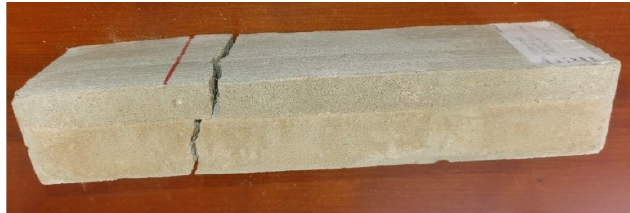
Figure 28. Detail of delamination- specimen 24030420.